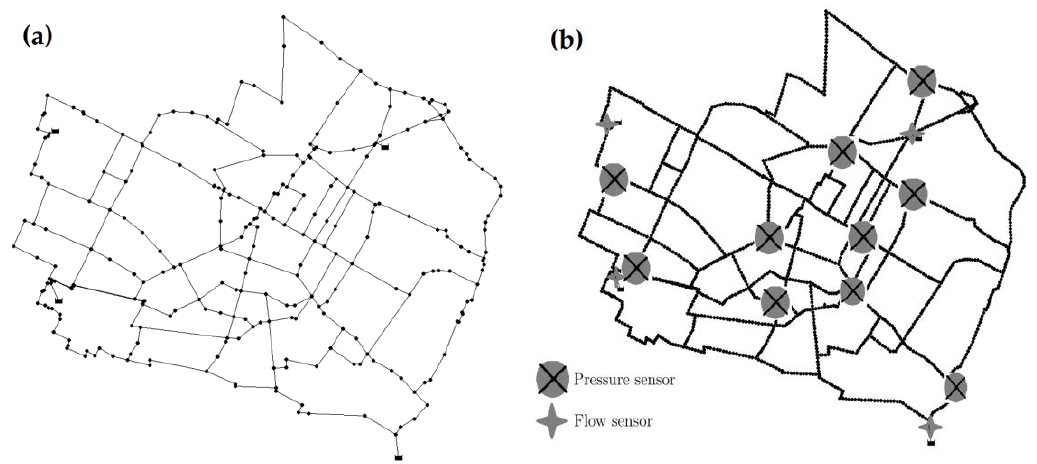
Figure 8. Modena network: ( a ) model network where the calibration processes are launched; ( b ) reference network where the measurements are taken.